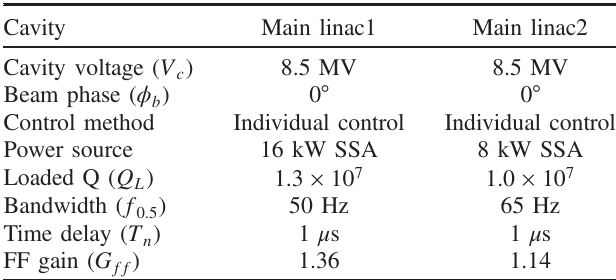
TABLE V. LLRF and cavity parameters of the main linac in the cERL.